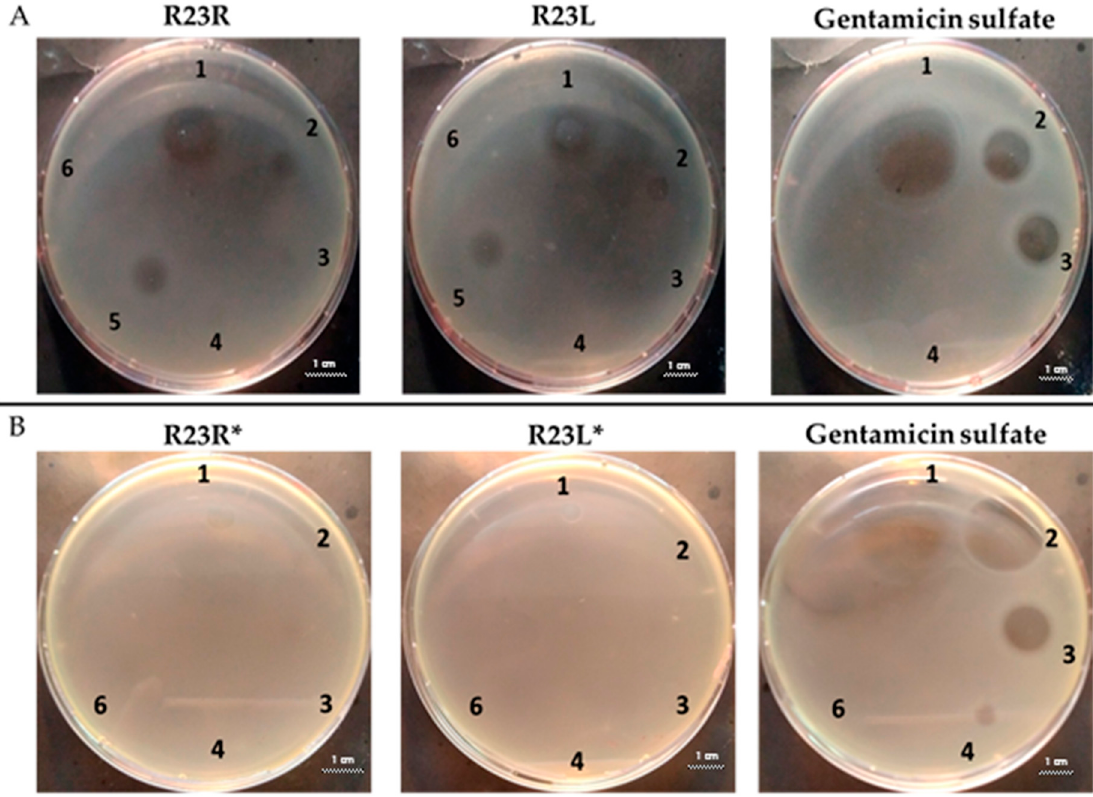
Figure 2. Inhibition zone assay after 24 h of co-incubation peptides R23R, R23L ( A ) and modified peptides R23R*, R23L* ( B ) with the cells P. aeruginosa (strain PA103). The test for the antibacterial effect of peptides was carried out according to the following scheme: 1 —peptide 3600–3800 µM (gentamicin sulfate 17,000 µM), 2 —peptide 360–380 µM (gentamicin sulfate 1700 µM), 3 —peptide 36–38 µM (gentamicin 170 µM), 4 —peptide 3.6–3.8 µM (gentamicin sulfate 17 µM), 5 —DMSO 100% (volume/volume), 6 —DMSO 20% (volume/volume). The scale bar is 1 cm. Table 3. Results of testing the antimicrobial properties of the R23R, R23L, R23R*, and R23L* peptides with the P. aeruginosa (strain ATCC 28753) cells. The scale bar is 1 cm. Photo of Results Scheme